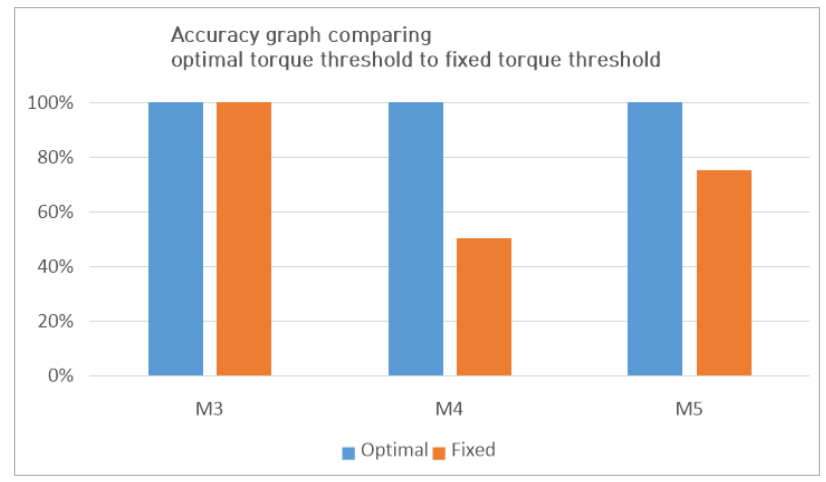
Figure 13. Accuracy graph (in percent) of optimal torque threshold (Optimal) and fixed torque threshold